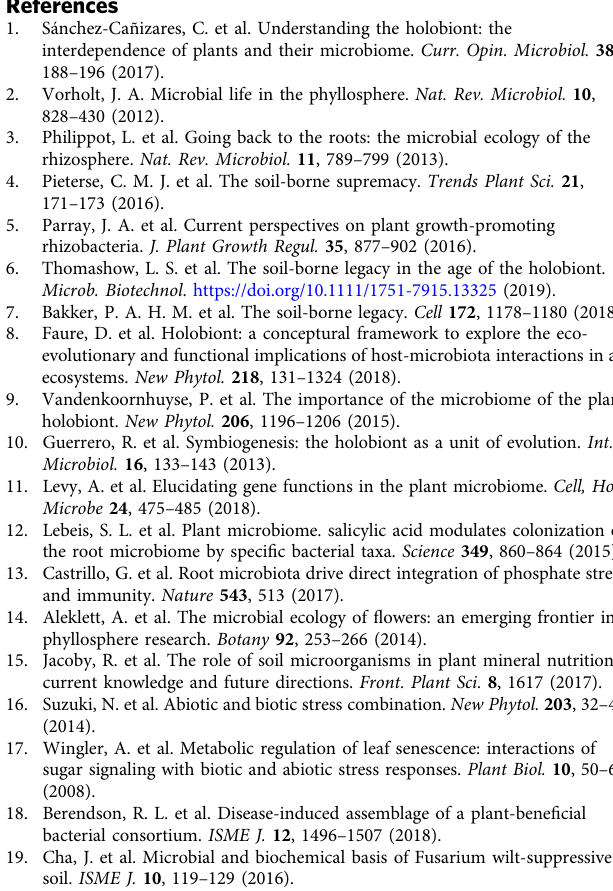
Supplementary Table 12. The source data underlying Figs. 1a, b, e – g, 2b – d, 3d, 4b, e, 5b, c, and 5d – f and Supplementary Figs. 4a – d are provided as a Source Data fi le. All other relevant data and resources are available from the